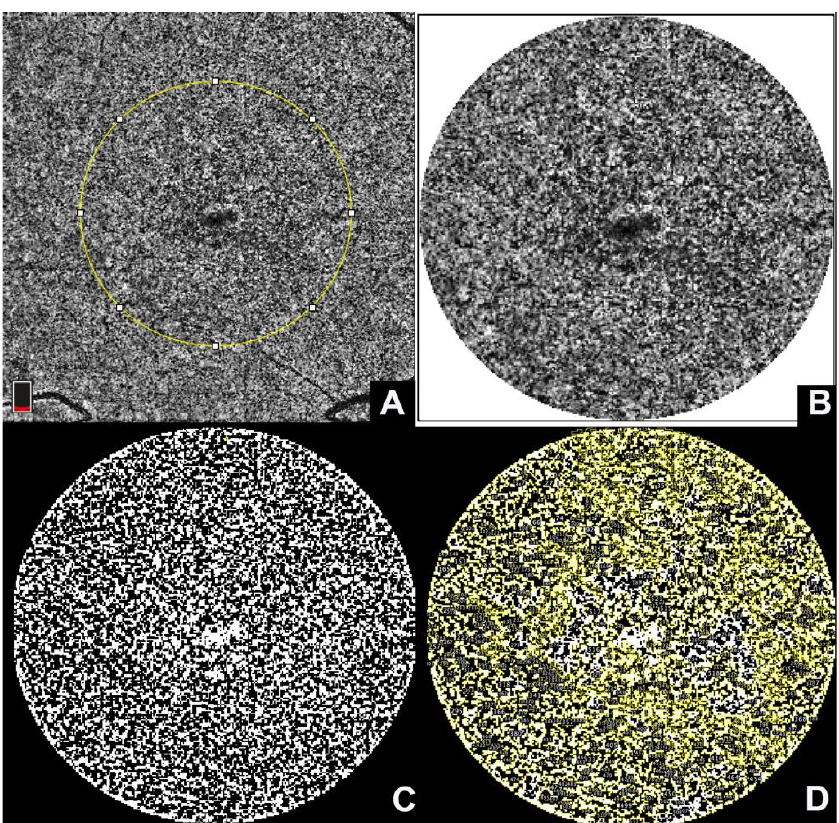
Figure 3. Choriocapillaris flow voids: ( A ) a choriocapillaris slab obtained through optical coherence tomography angiography. The yellow circle represents a region of interest chosen for processing. ( B ) The region of interest is then cropped using a circular selection of 1 mm and ( C ) imported into Fiji software for binarization using autolocal threshold with Phansalkar method; ( D ) the binarized slab is analyzed using the “Analyze Particles” tool that automatically counts the flow deficits.